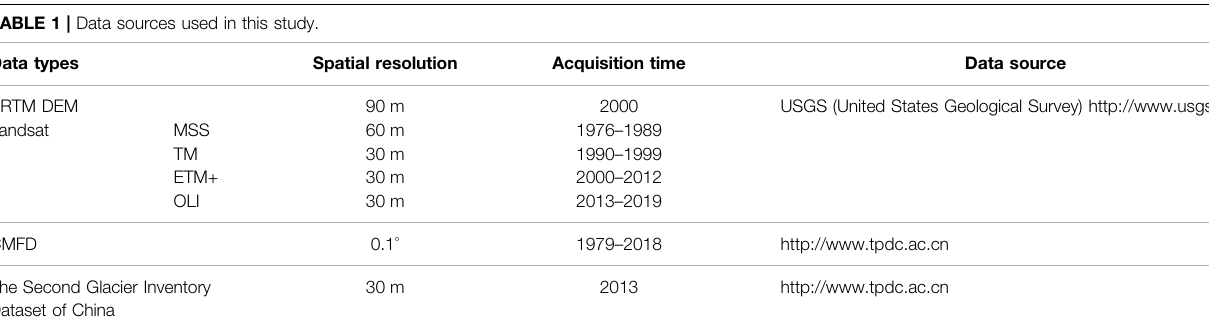
TABLE 1 | Data sources used in this